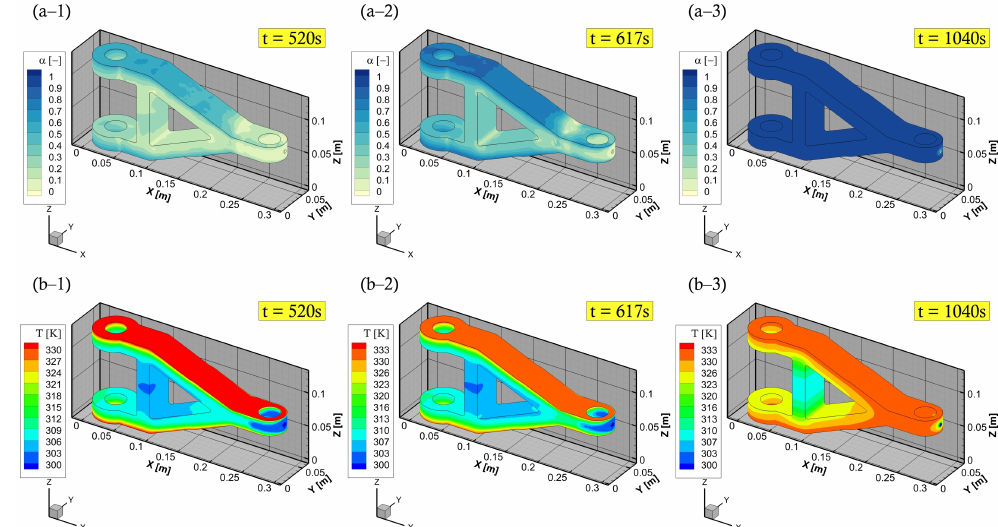
Figure 10. Cure stage of torque link: ( a ) degree of cure (cure finished); and ( b ) temperature distribu-